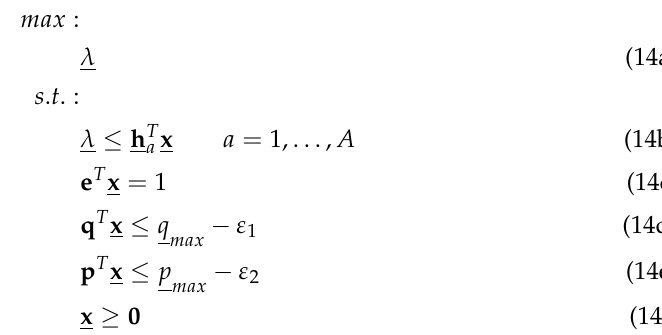
Table 1. Survival time payoffs for the defender 2 × 2 game.